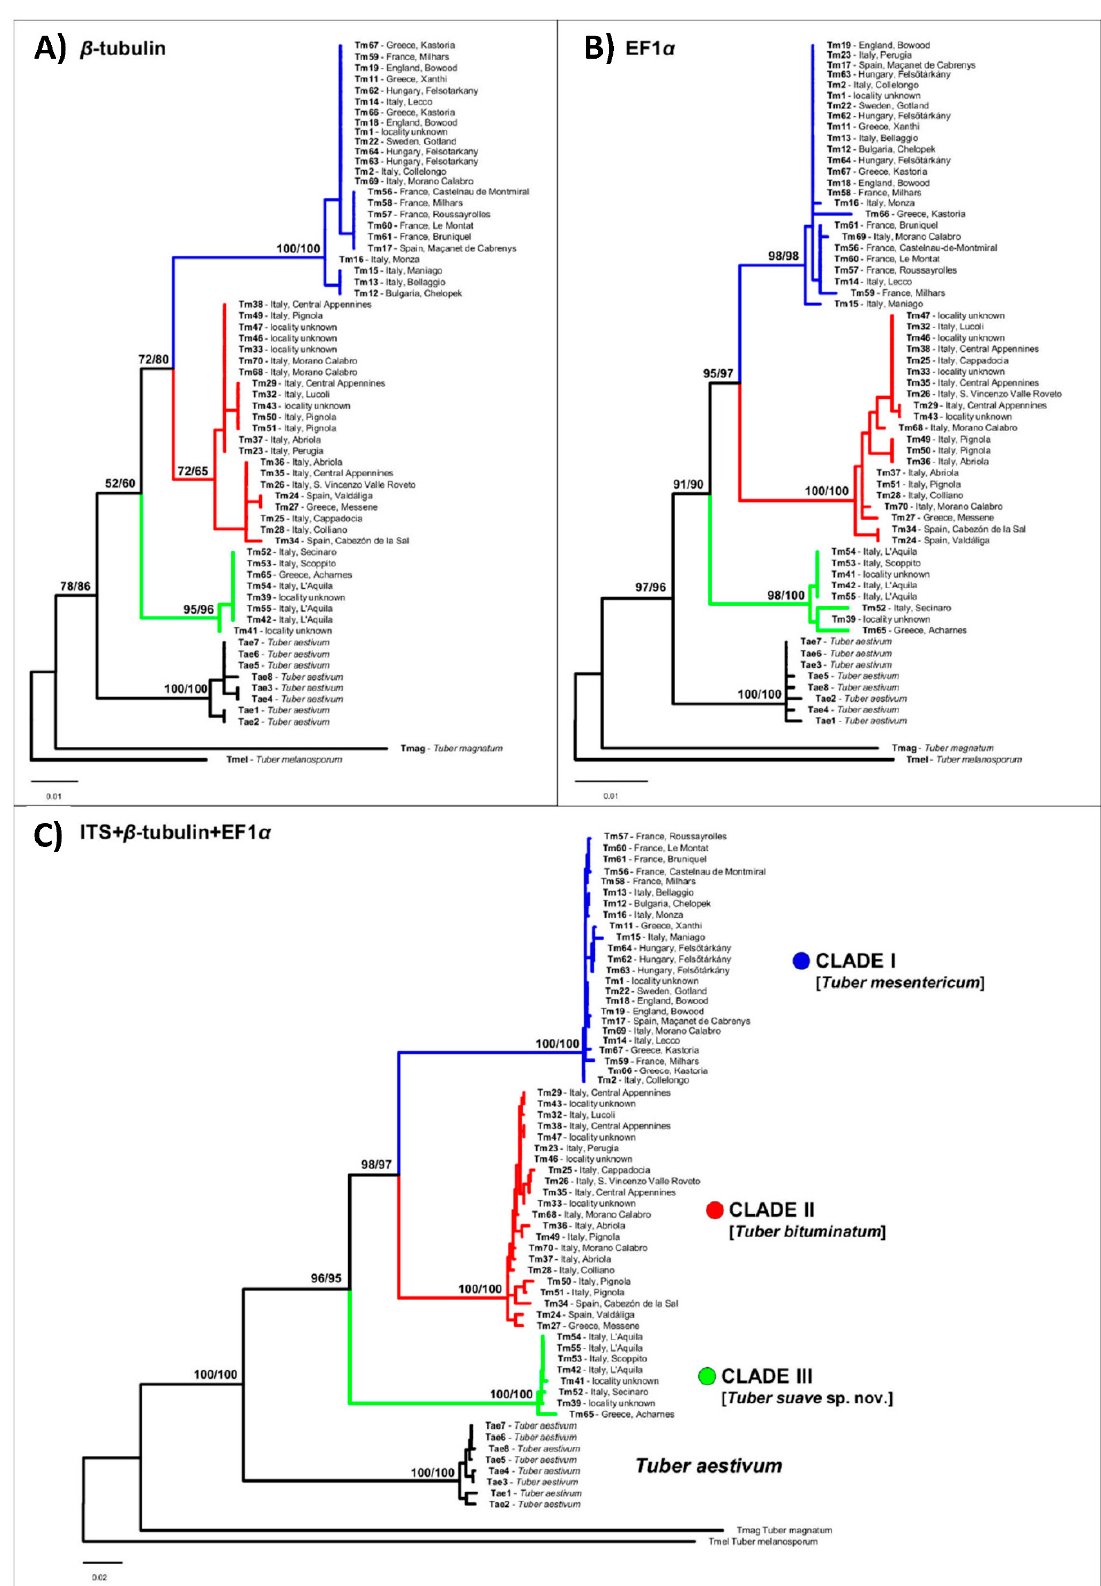
Figure 1. Phylogeny of T. mesentericum complex based on the single-loci datasets of β -tubulin ( A ) and elongation factor 1- α ( B ) and the concatenated dataset ITS + β -tub + EF-1- α ( C ). Bootstrap (BS) and rapid bootstrap (rBS) values (>70) are reported on nodes. Specimens are labelled by their geographic origin and ID, listed in Tables 1 and S1.